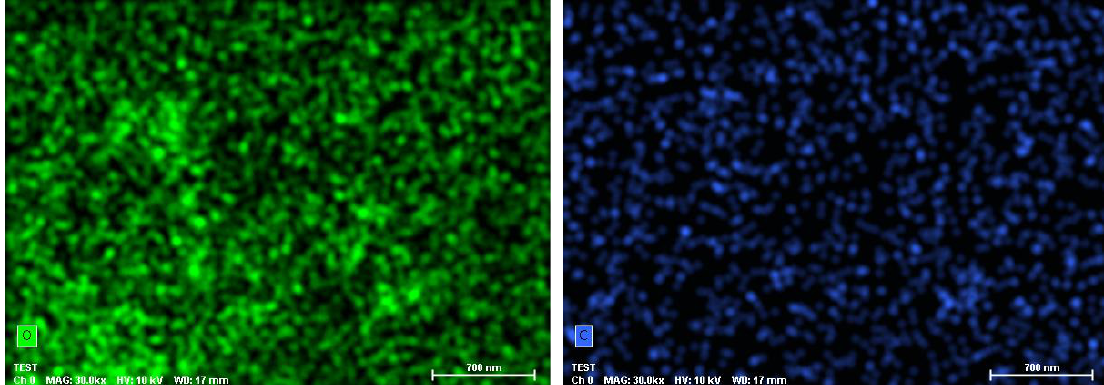
Figure 3. The EDS analysis results of the MgO/Mg composites.